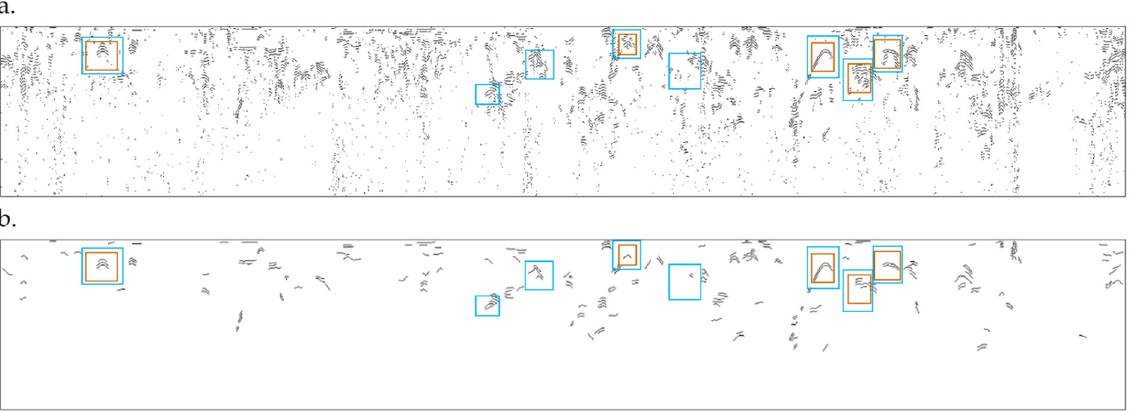
Figure 11. Results of introducing the condition of the size of underground object: ( a ) target image before introducing the C S condition; ( b ) image after introducing the C S condition.